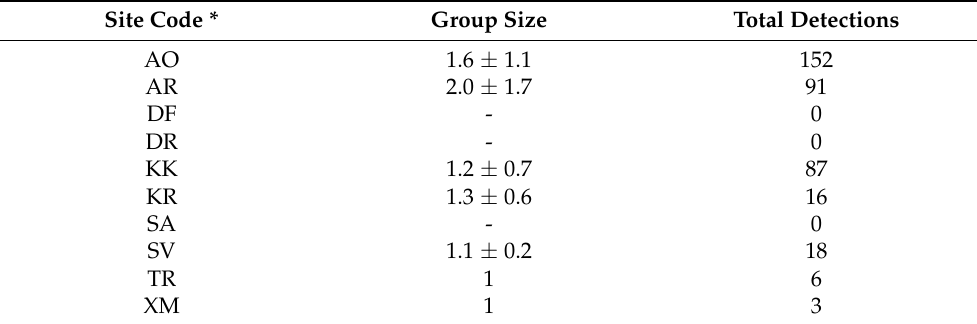
Table 5. Mean group size of mouflons per monitored water trough (includes solitary animal